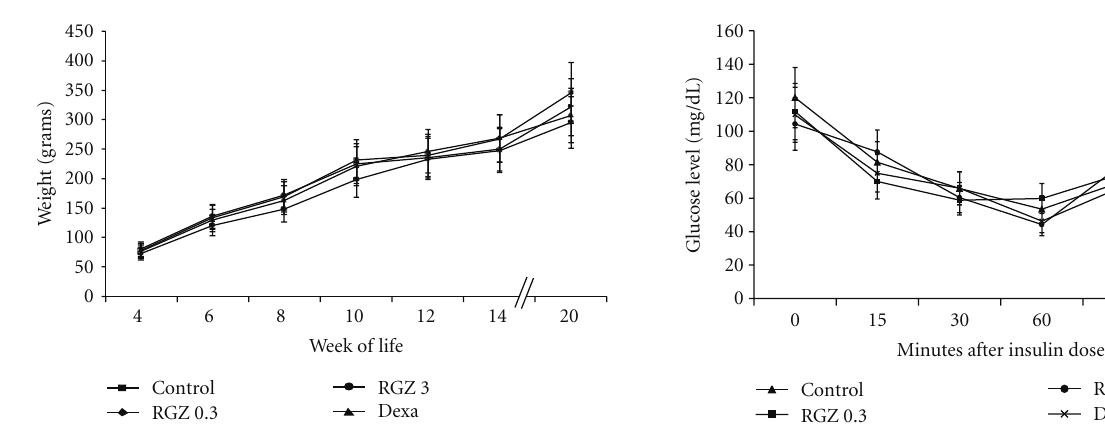
Figure 3: E ff ect of RGZ on insulin tolerance test (ITT). At 12 weeks of age, insulin was administered at 1unit/kg body weight subcutaneously after an overnight fast. Glucose was assayed at time = 0 (baseline), 15, 30, 60, 120, and 180 minutes following insulin administration. There were no significant di ff erences in serum glucose values between the treated and control groups during any of the time points of the ITT ( P > 0 .